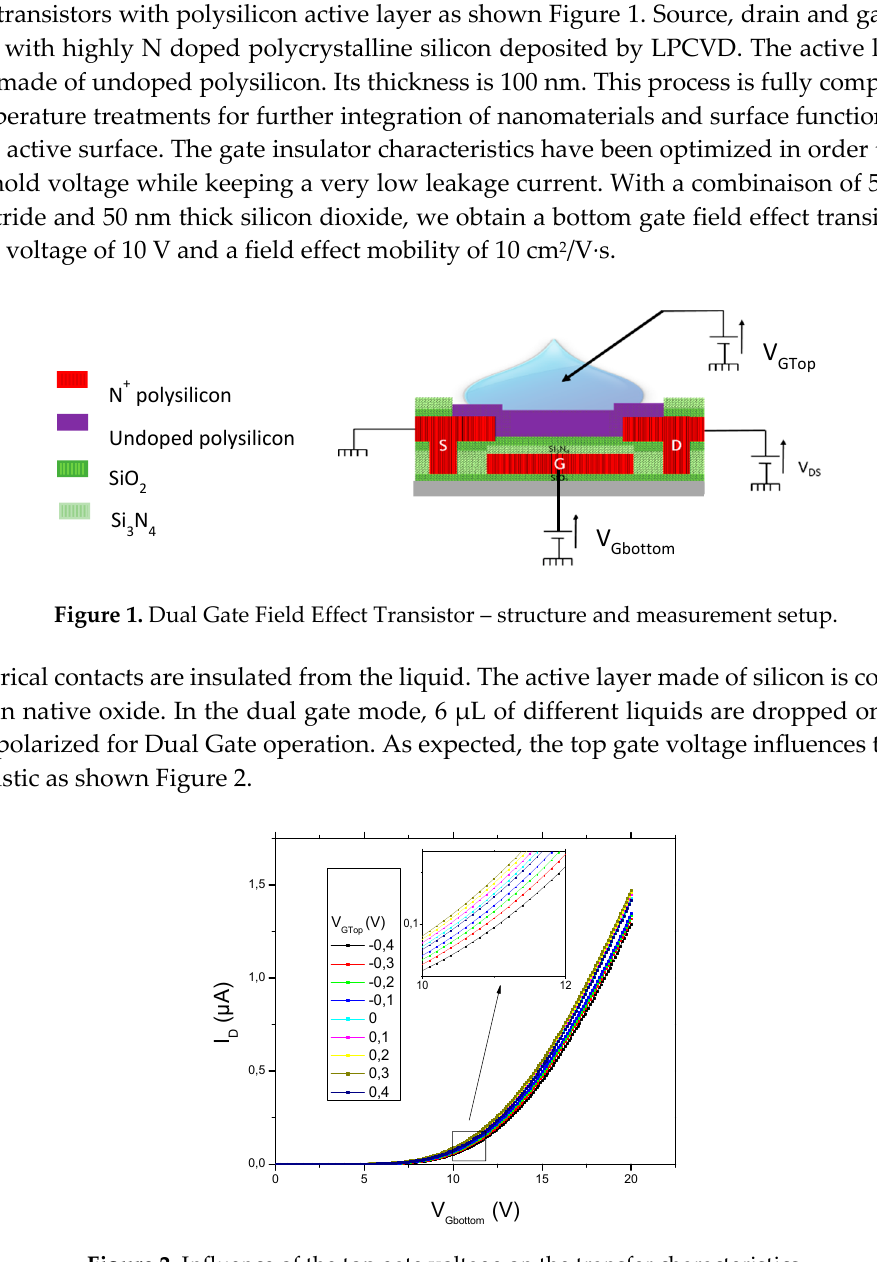
Figure 2. Influence of the top gate voltage on the transfer